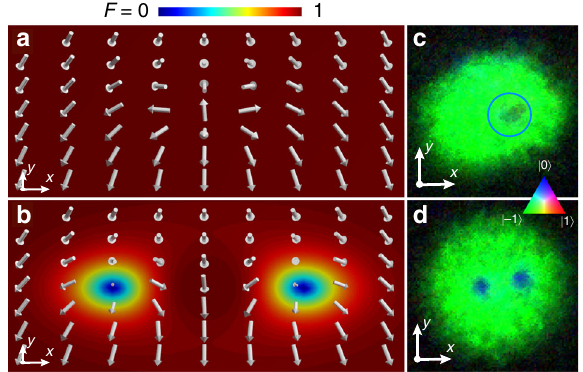
Fig. 4 Theoretical spin textures and corresponding experimental data. a The characteristic fountain-like spin texture of the initial non-singular vortex, with spin magnitude one everywhere. b The spin texture of the relaxed vortex state. The background colour indicates spin magnitude, showing the fi lled vortex cores. c , d Experimentally obtained composite colour images of the corresponding structures using the data of Fig. 3, where the colours indicate the spinor components. In the absence of atoms in the m = 1 spinor component, pure blue represents the P phase and pure green represents the ferromagnetic phase. The fi eld of view of c , d is 219 μ m × 219 μ m. Source data are provided as a Source Data fi le